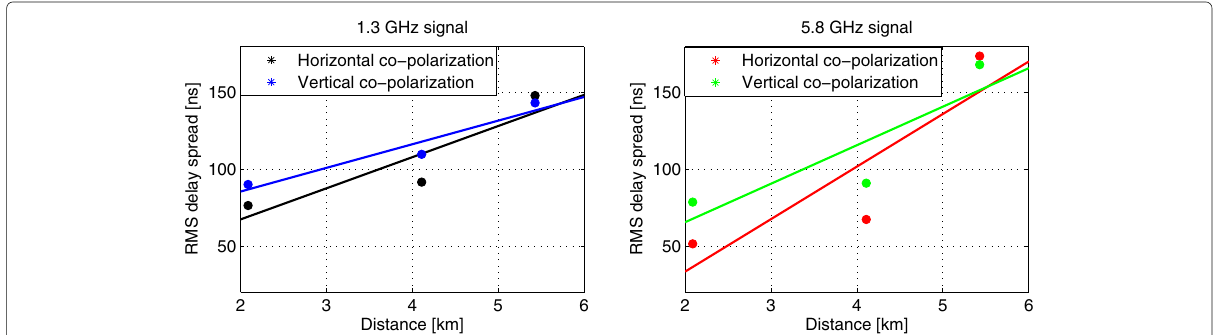
Fig. 11 Root mean square delay spread versus distance. The mean values of root mean square delay spread as a function of transmitter-receiver distance for different frequencies and co-polarizations in a non-line of sight